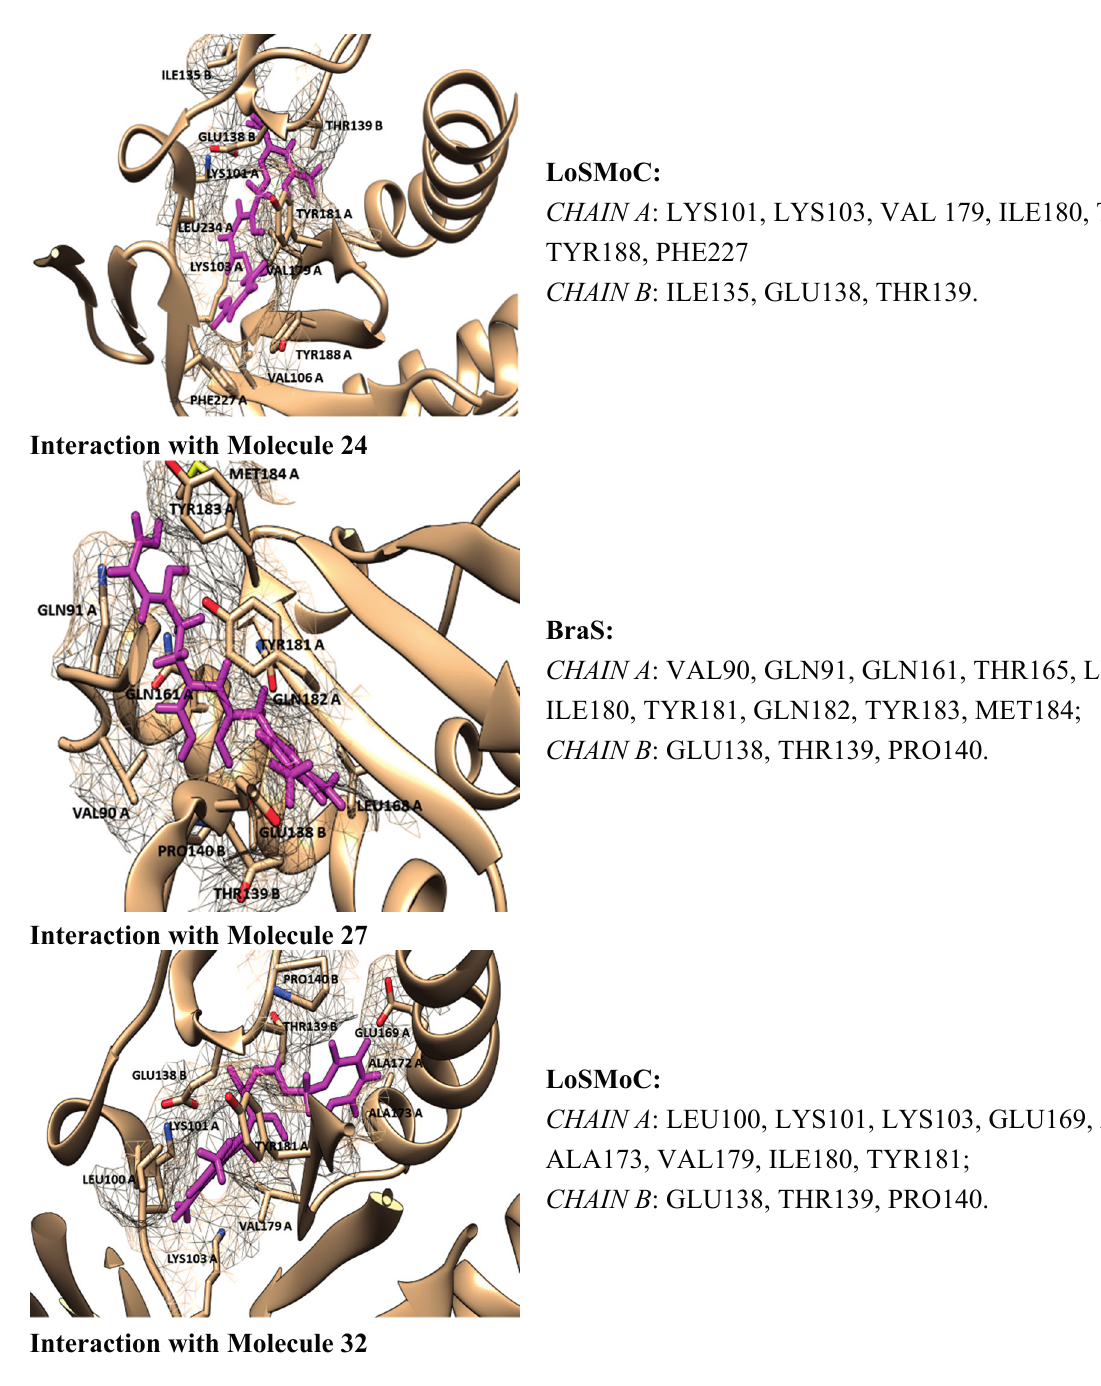
Figure 5. ContPro [117] results for interacting residues with selected molecules at 3.5 Å by the present Genuine-LoSMoC-BraS double variational procedure, in their relevant configuration(s), see text for